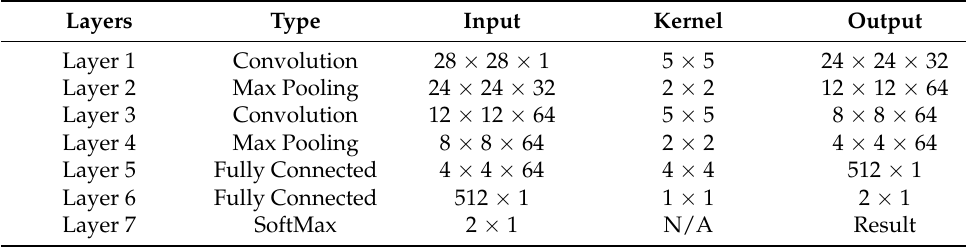
Figure 8. Basic Architecture of CNN. Table 4. Parameters used in CNN architecture.